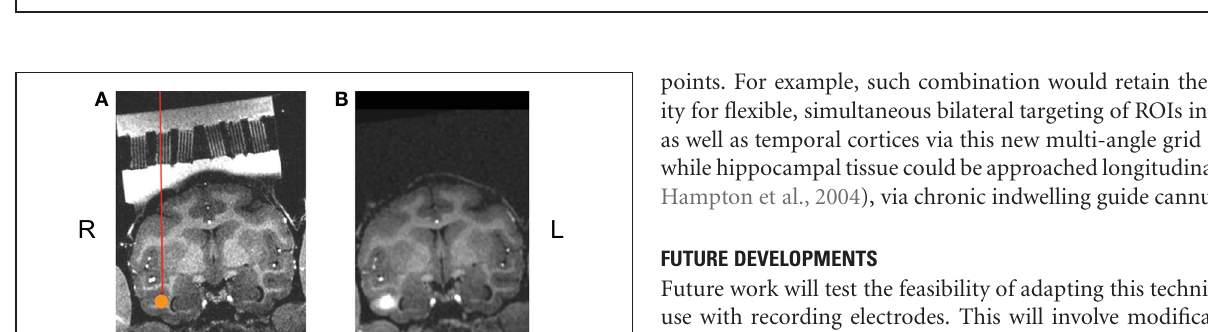
FIGURE 7 | (A) One ROI, shown here in the coronal plane, rotated into the coordinate system of the guide grid, the ROI marked as an orange disk. (B) The actual injection results made though this angled